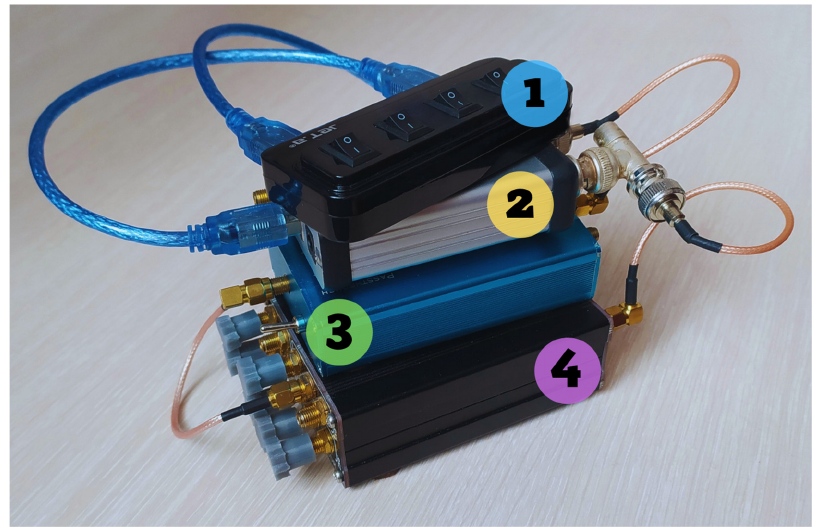
Figure 3. Photo of the assembled model of the ionosonde receiving part without a control PC. The numbers indicate: 1—USB hub, 2—precision GPS reference clock, 3—upconverter, 4—LimeSDR.